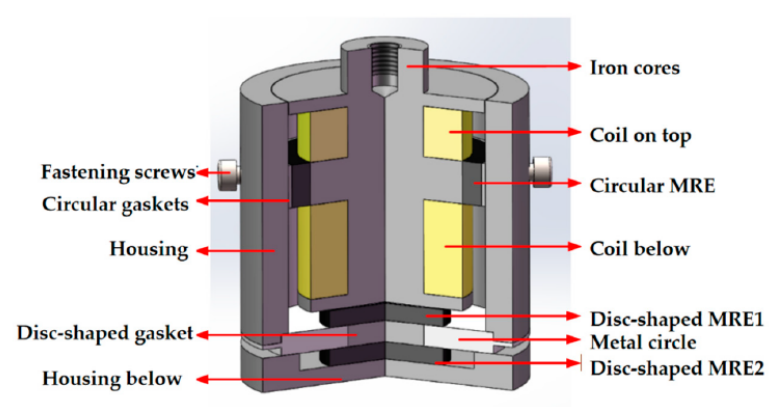
Figure 11. The example of vibration insulator (source: [119]).